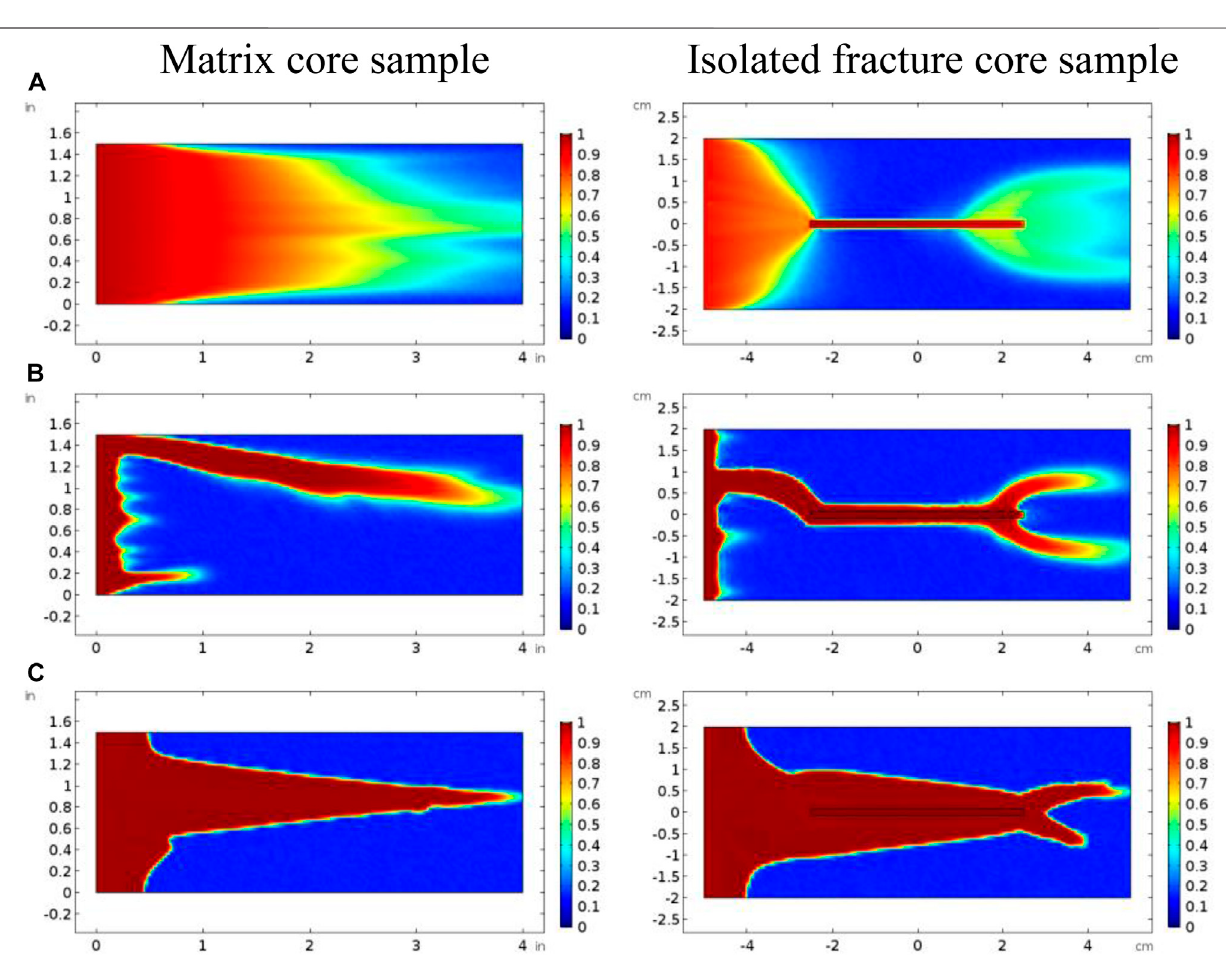
Frontiers in Earth Science |